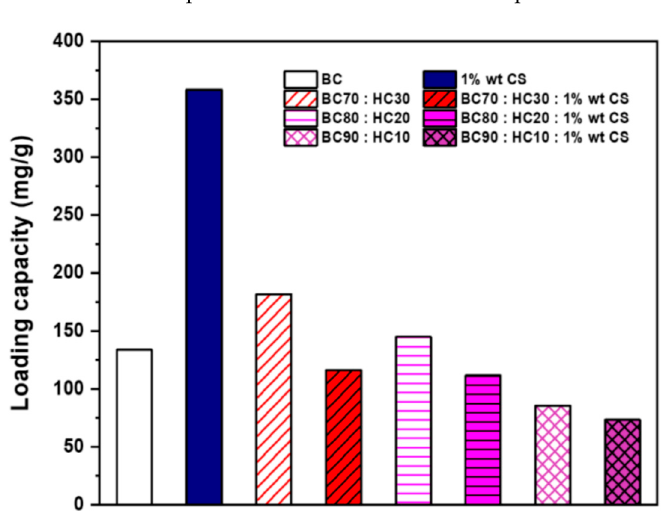
Figure 7. The ascorbic acid loading capacity of films.